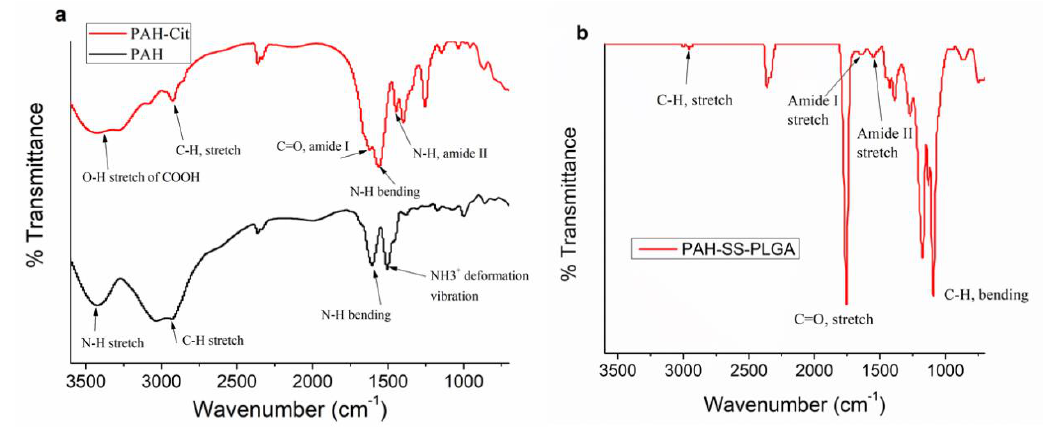
Figure 2. FTIR peak of ( a ) PAH, PAH-Cit, and ( b ) PAH-SS-PLGA.